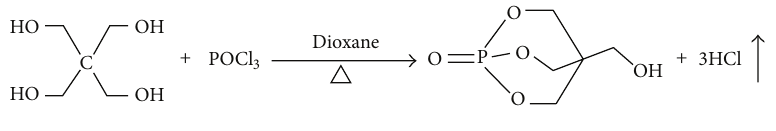
Scheme 1: Synthetic route of